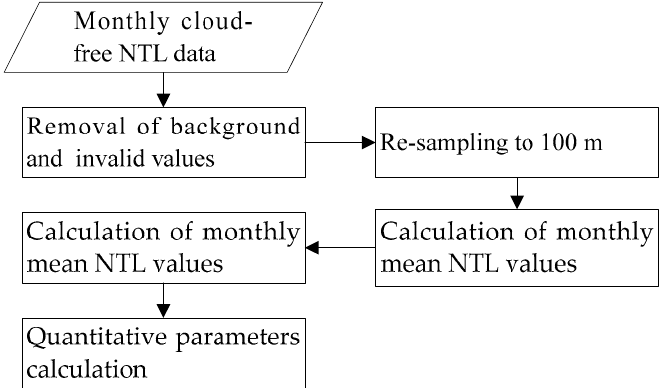
ISPRS Int. J. Geo-Inf. 2022 , 10 , x FOR PEER REVIEW Figure 3. Flowchart of the preprocessing of NTL data. Figure 3. Flowchart of the preprocessing of NTL data.